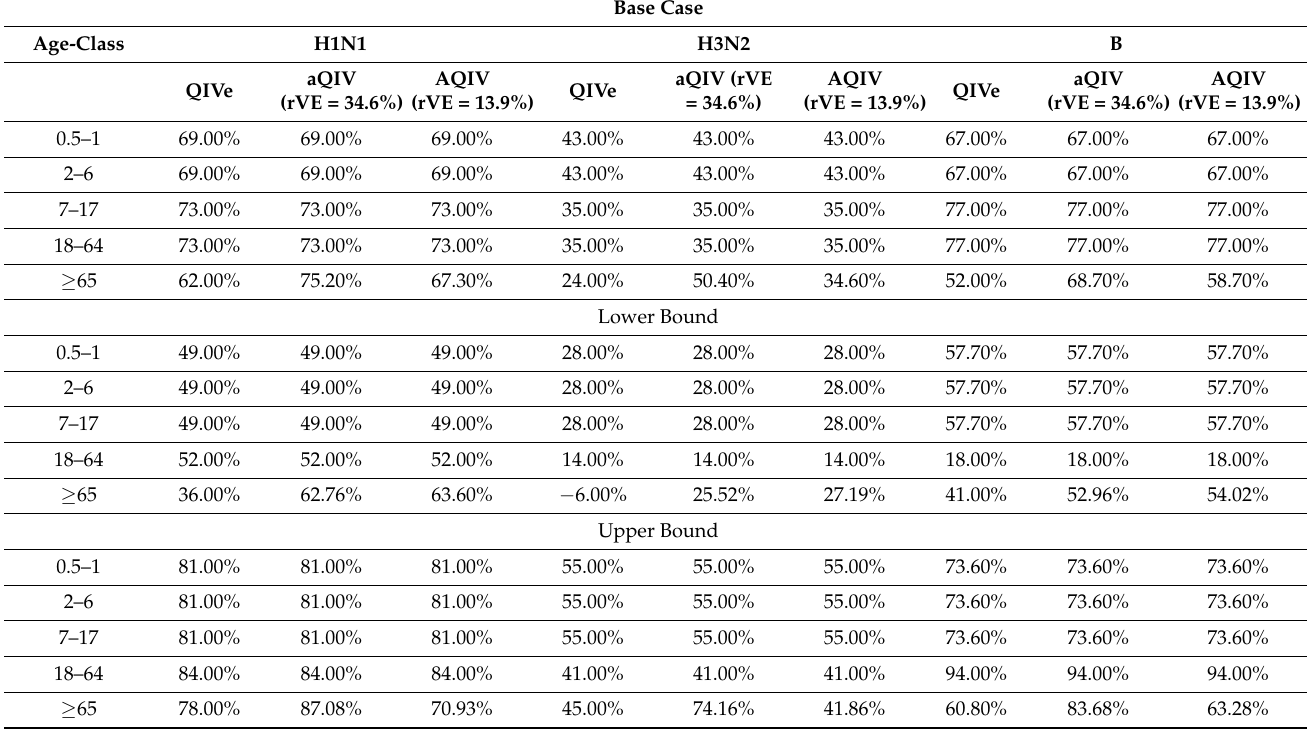
Table A5. Lower and upper bounds for vaccine effectiveness in DSA.